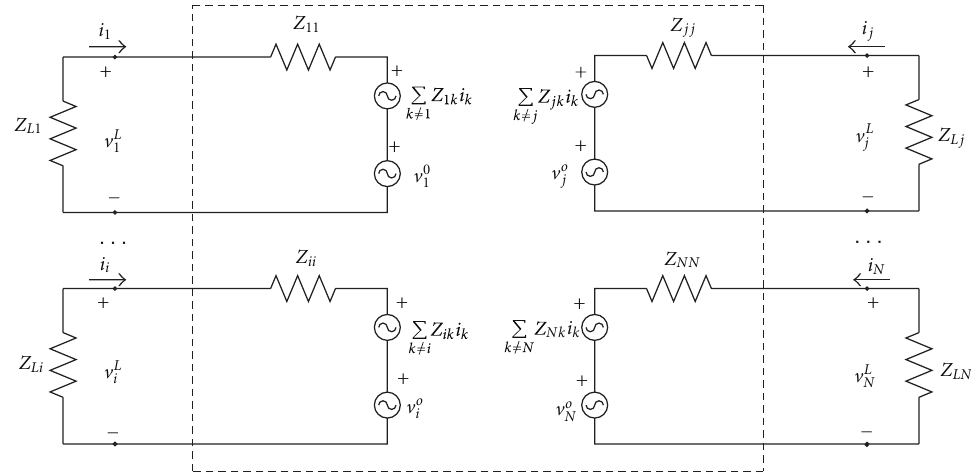
Figure 1: Circuit model for analyzing antenna coupling e ff ects. Superscript “ o ” denotes open circuit voltage, and subscripts i , j denote particular elements of the array. Z L is the load impedance, N is the total number of antennas.